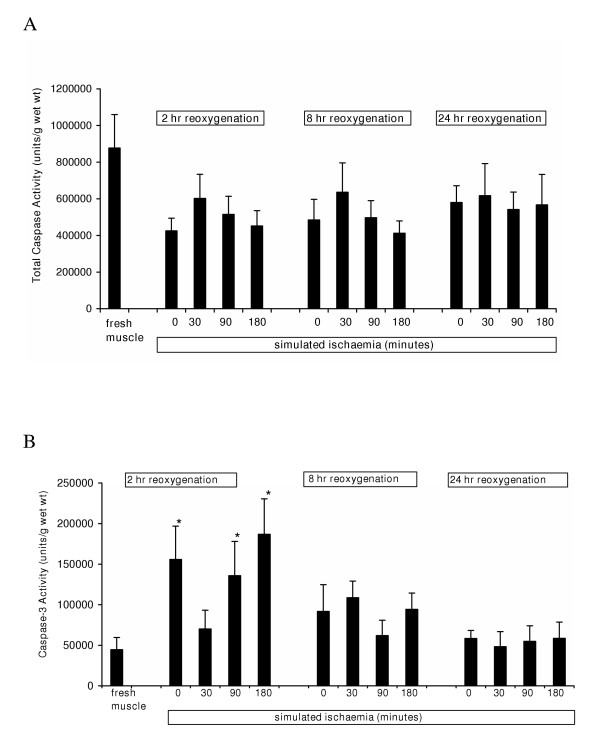
Total caspase activity (A) and caspase-3-like activity (B) in right atrial muscles subjected to various periods of simulated ischaemia followed by various periods of reoxygenation. The columns represent the mean of 8 experiments and the bars represent the SEM. *p < 0.05 vs fresh muscle